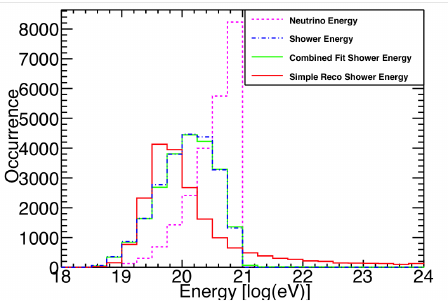
Figure 1. Decomposition in singular values SV1, SV2, and SV3 of the hit distribution in the detector for neutrinos (green, band in SV1-SV2 plane) and background (red, band with pronounced SV3 component) as described in the text. The neutrino signals can be e ff ectively discriminated from the background with a cut on the SV3 parameter (spread of data points in direction perpendicular to the fitted plane).